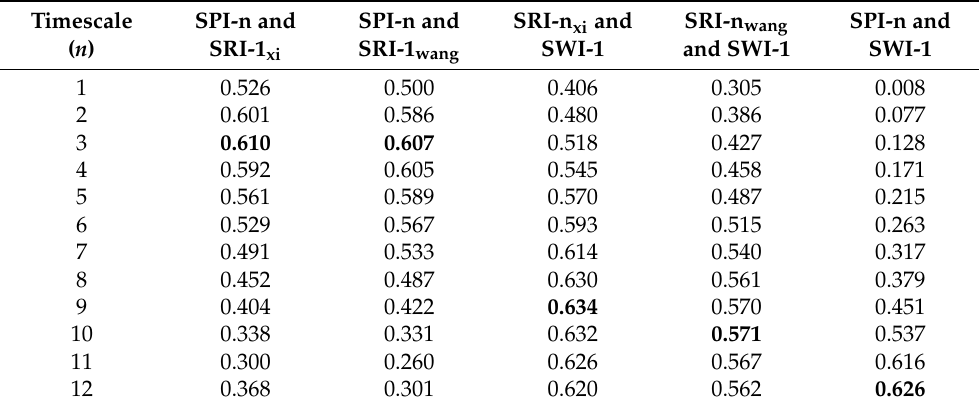
Table 4. Correlation coefficients between the meteorological drought and hydrological drought